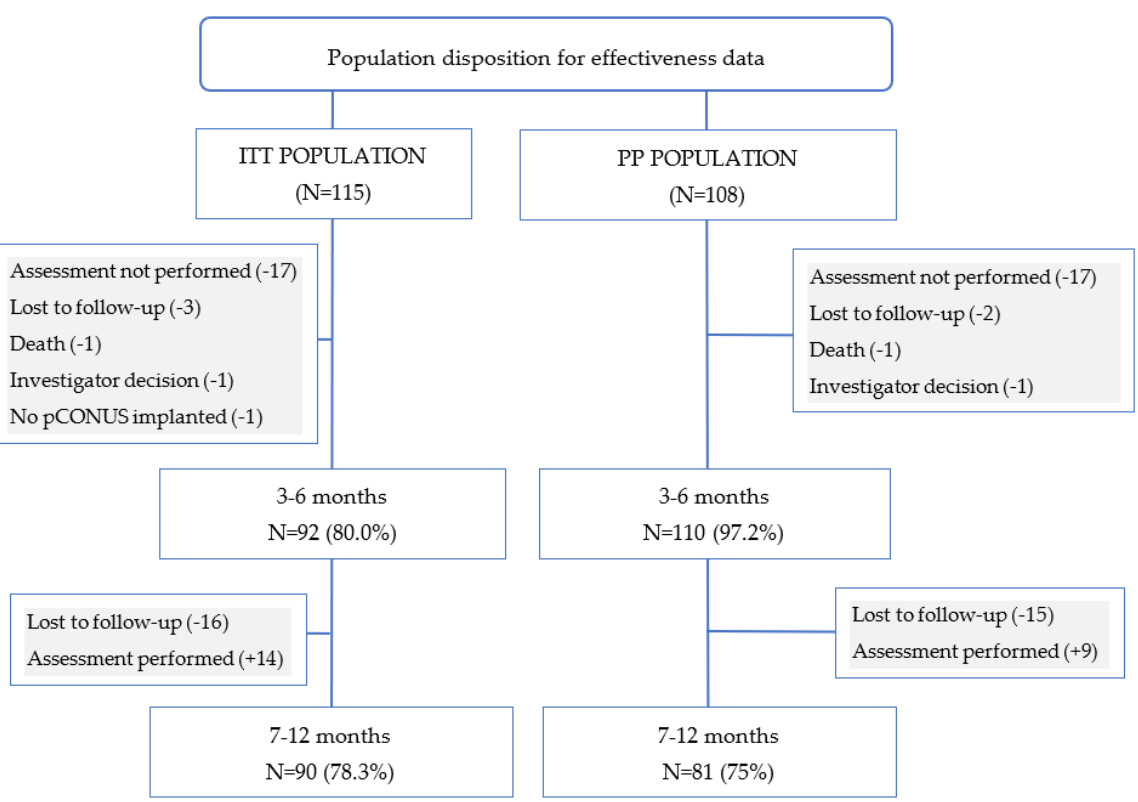
Figure 1. Population disposition for effectiveness at 3–6- and 7–12-month follow-ups. “Lost to follow-up” means the centers could not contact the patients despite using different techniques (e.g., letter, phone call, email), so the patients exited the study. “Exam not available” means the patient did not attend this follow-up, but may have attended a later one. PP: per-protocol population; ITT: intent-to-treat